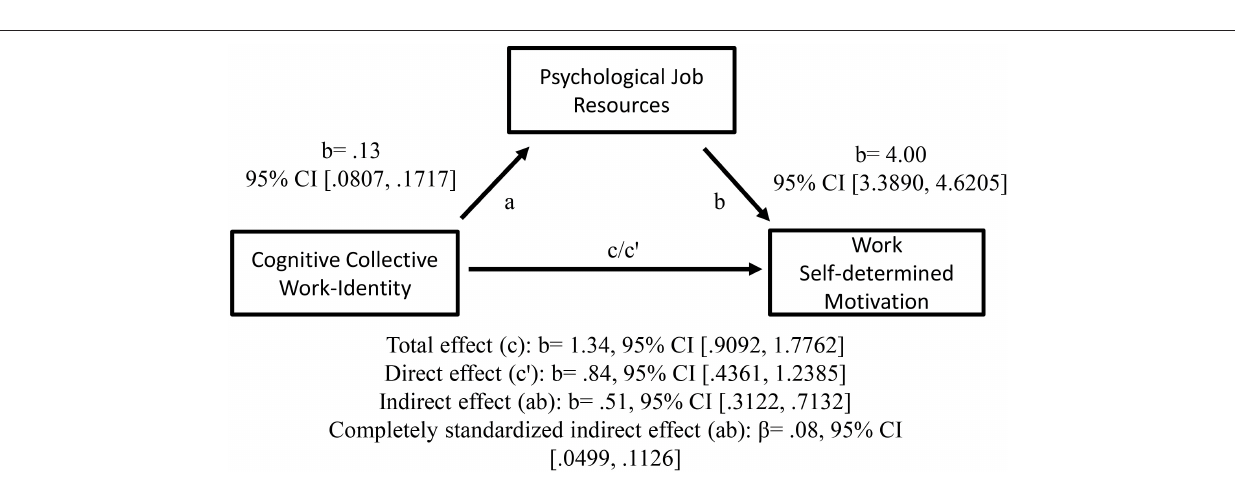
by the Job Demand-Resource model (Demerouti et